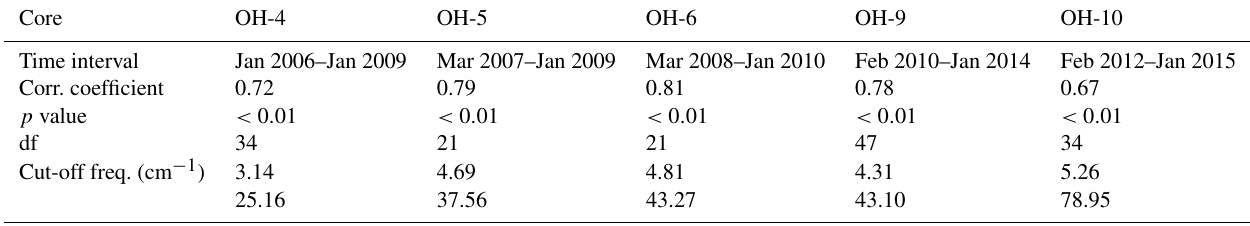
Table 4. Correlation between deuterium excess ( d excess meteo ) values calculated from monthly mean meteorological data (SST and rh) and water stable isotope monthly means for all cores used in this study. Degrees of freedom (df) defined as: n − 2 for each correlation and cut-off frequencies for the FFT analysis are cm − 1 , expressing the lower and upper boundary of the integrated spectrum, respectively. Core OH-4